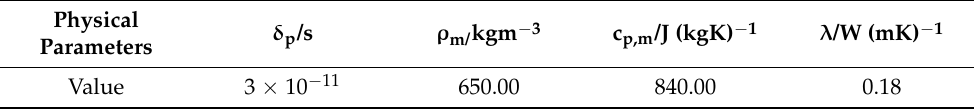
Table 2. The physical parameters of wall [38].